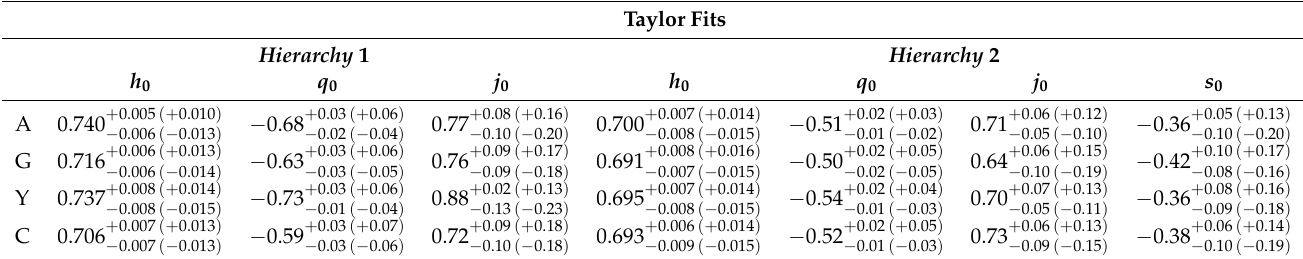
Table 3. Cosmographic best fits and 1– σ (2– σ ) errors from Taylor expansions labeled as hierarchy 1 ( h 0 , q 0 , j 0 ) and hierarchy 2 ( h 0 , q 0 , j 0 , s 0 ). Letters A, G, Y, and C indicate Amati, Ghirlanda, Yonetoku, and Combo correlations, respectively.